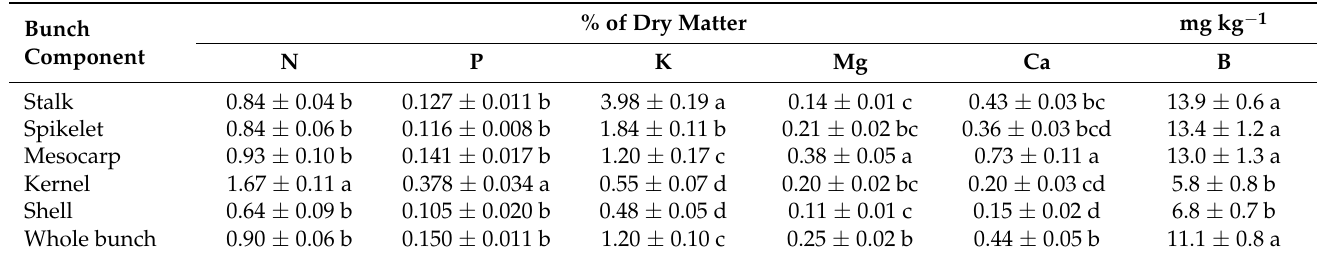
Table 8. Nutrient concentrations (mean ± SE) in fresh fruit bunches and their components in tenera oil palm. ( n = 22 ripe bunches harvested from different ages of palms).